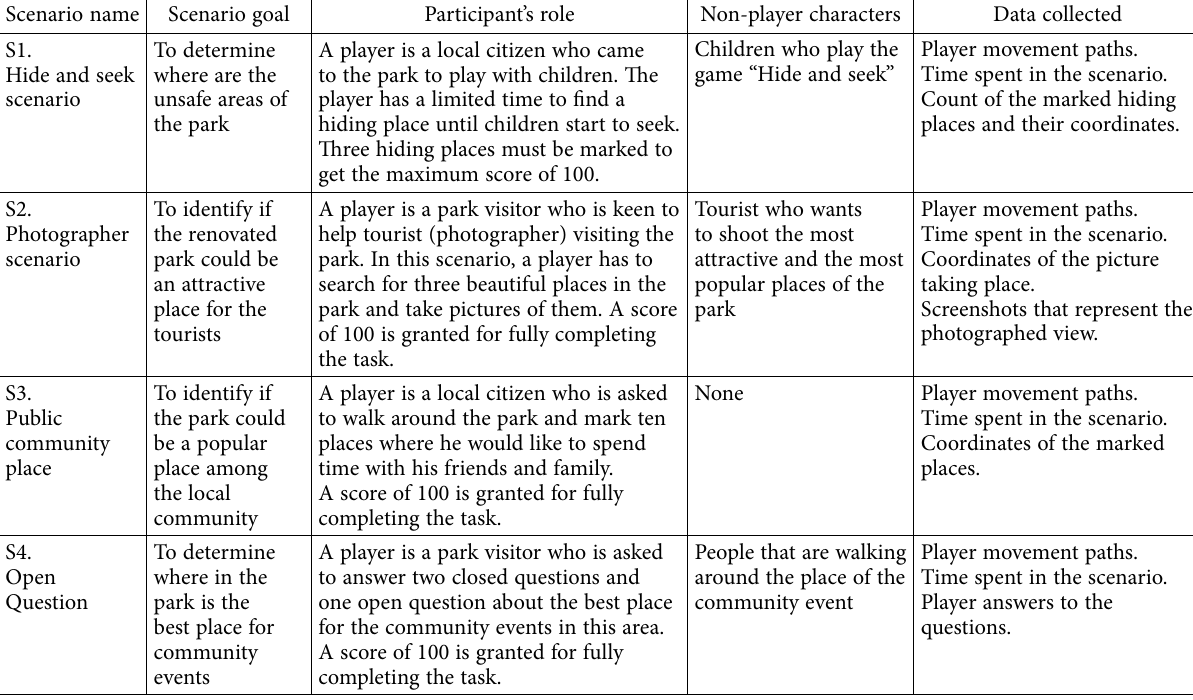
Table 2. Summary of the implemented scenarios and their